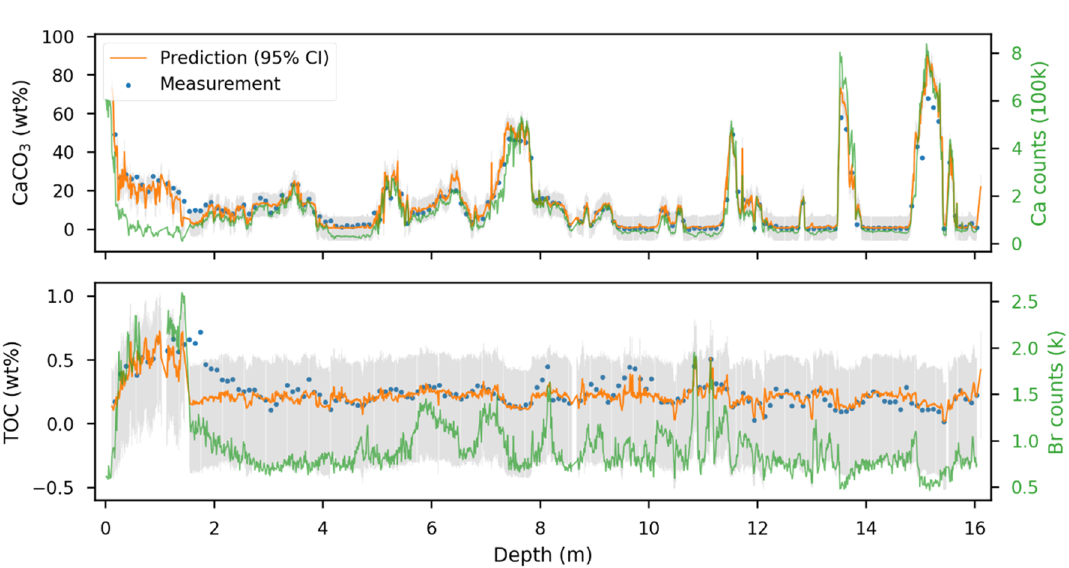
Figure 6. Measured (blue dots) and predicted (orange lines with 95% confident intervals in gray) values for